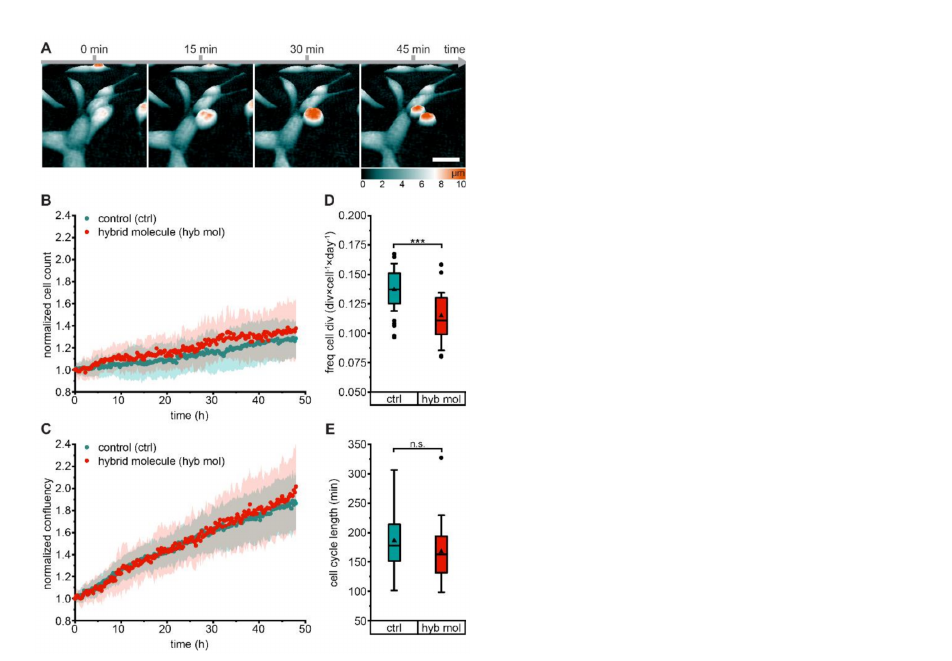
Figure 3. Holographic time-lapse imaging of LNCaP cell proliferation under compound exposure. LNCaP cell proliferation was followed for a total period of 48 h in the absence of (control, cyan, experiments n = 38, tracked cells n = 33,031, divisions n = 9157, Supplemental Movie S1) and in the constant presence of 100 nmol/L PSMA-927 (hybrid molecule, red, experiments n = 25, tracked cells n = 35,804, divisions n = 8421) via holographic time-lapse cytometry. ( A ) Holographic image sequences of a cell division in the presence of compound. Dividing cells rounded up and could be distinguished from nondividing cells by height (color-coded); scale bar, 50 µ m. A corresponding time-lapse movie (Supplemental Movie S2) is supplied. ( B ) Normalized cell count (average p -value 0.235 ± 0.227) and ( C ) normalized confluency (average p -value 0.546 ± 0.251) of untreated and treated LNCaP cells. ( D ) Frequency of cell division and ( E ) cell cycle length of untreated and treated LNCaP cells. Significance: *** p < 0.001; ns, no significant differences.